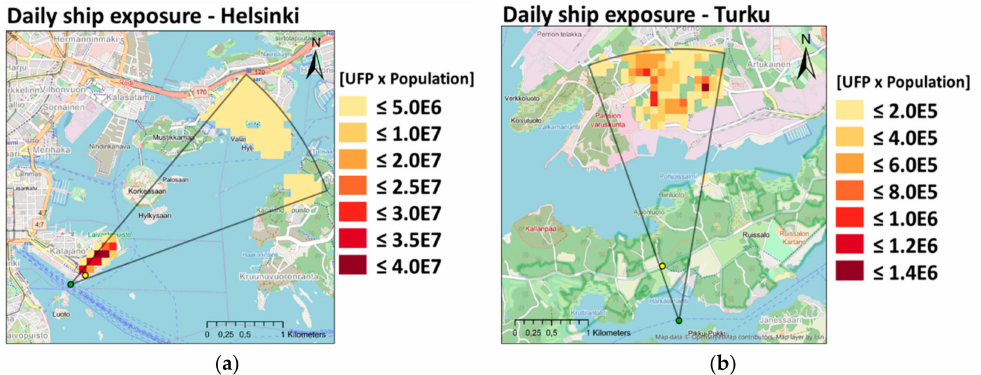
Figure 6. Predicted daily population exposure (cm − 3 x number of people) in Helsinki and Turku in the microenvironment home during winter: ( a ) Helsinki (based on event A_20110111); ( b ) Turku (based on event J_20110217). Outline indicates the impact area of the ship; green dot marks ship location; yellow dot marks Sni ff er location. The results include the estimated exposure from ships, assuming no other emission sources; we also assumed a constant wind direction and a constant urban background UFP